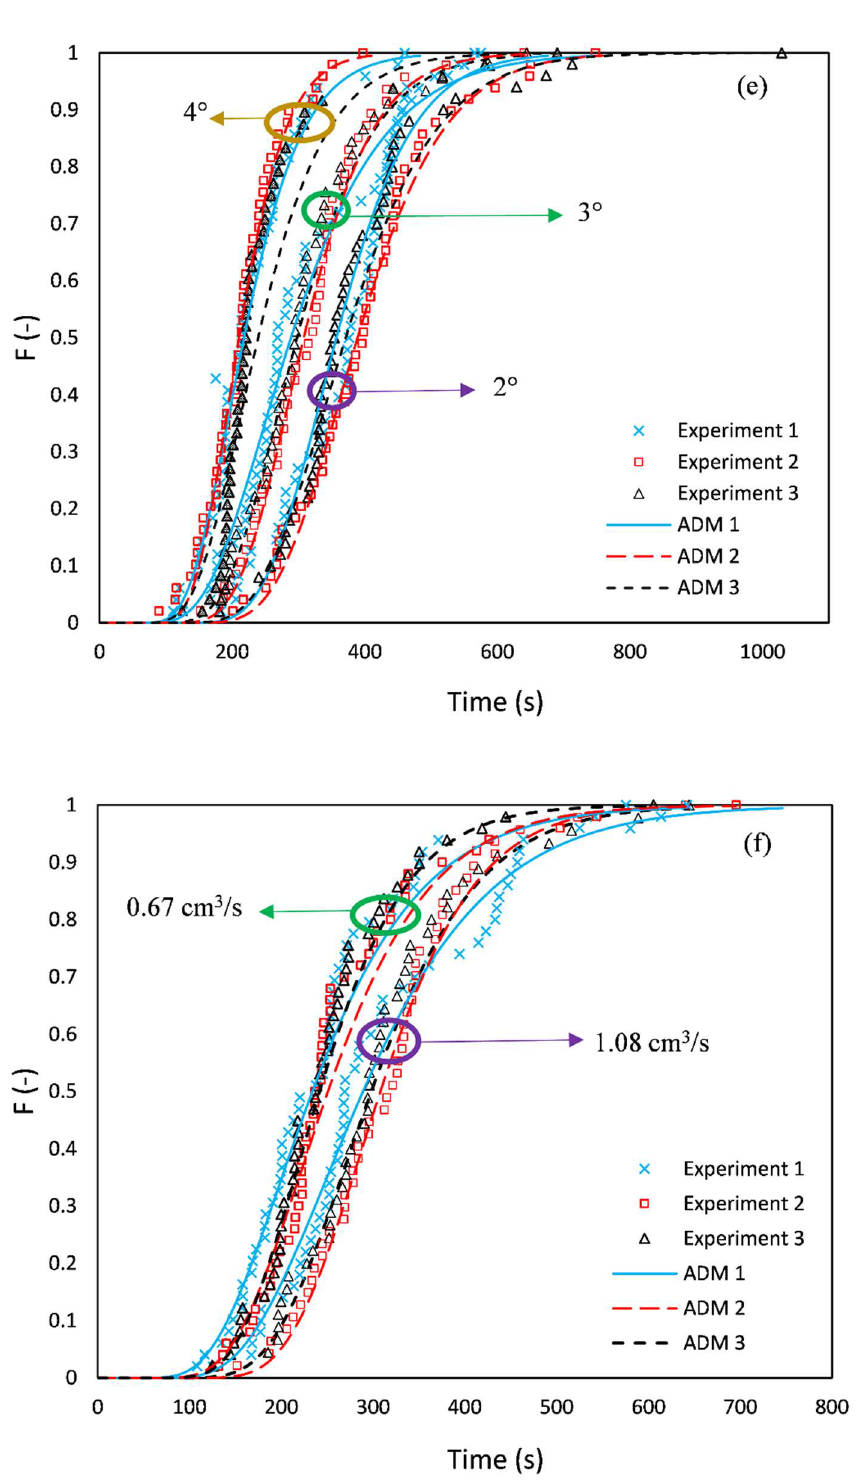
Figure 5 . Cumulative distribution as a function of outlet time in experiments and fitted with ADM ( a ) 3 rpm, 3 ◦ , and 1.08 cm 3 /s for 6 mm cubes; ( b ) 7 rpm, 3 ◦ , and 1.08 cm 3 /s for 6 mm cubes; ( c ) 11 rpm, ( a ) 3 rpm, 3°, and 1.08 cm 3 /s for 6 mm cubes; ( b ) 7 rpm, 3°, and 1.08 cm 3 /s for 6 mm cubes; ( c ) 11 rpm, 3 ◦ , and 1.08 cm 3 /s for 6 mm cubes; ( d ) 3–11 rpm, 3 ◦ and 1.08 cm 3 /s for 6 mm cubes; ( e ) 3 rpm, 3°, and 1.08 cm 3 /s for 6 mm cubes; ( d ) 3–11 rpm, 3° and 1.08 cm 3 /s for 6 mm cubes; ( e ) 3 rpm, 2–4° 2–4 ◦ and 1.08 cm 3 /s for 6 mm cubes; ( f ) 3 rpm, 3 ◦ and 0.67 and 1.08 cm 3 /s for 6 mm cubes. (Each and 1.08 cm 3 /s for 6 mm cubes; ( f ) 3 rpm, 3° and 0.67 and 1.08 cm 3 /s for 6 mm cubes. (Each experiment repeated 3 times and ADM model was fitted on the three sets of experiment repeated 3 times and ADM model was fitted on the three sets of data.)